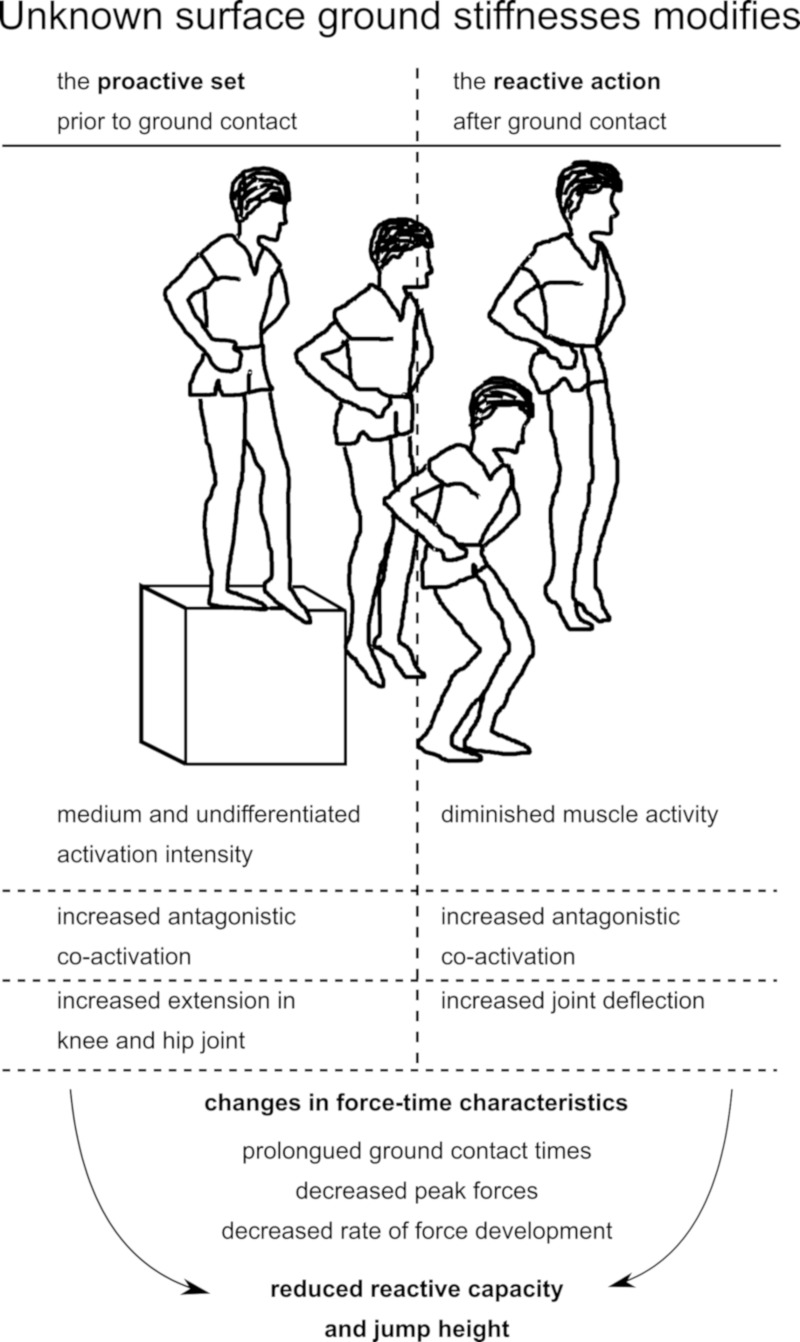
Neuromuscular and kinematic changes due to unknown ground stiffness.Changes are clustered according to the proactive (before touch-down) and reactive (after ground contact) phases of the jump.